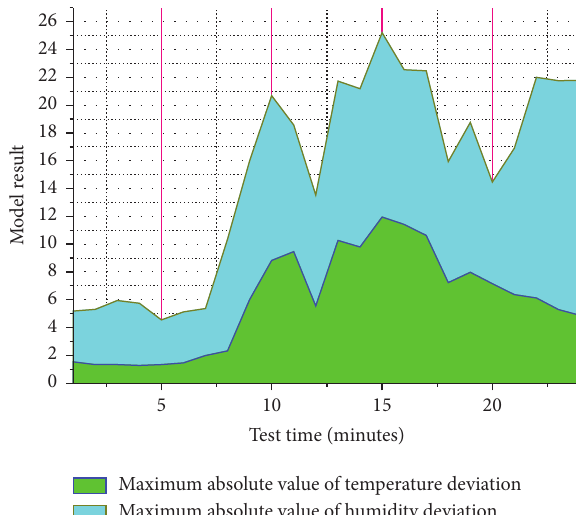
Figure 6: Maximum values of absolute temperature and humidity deviations.